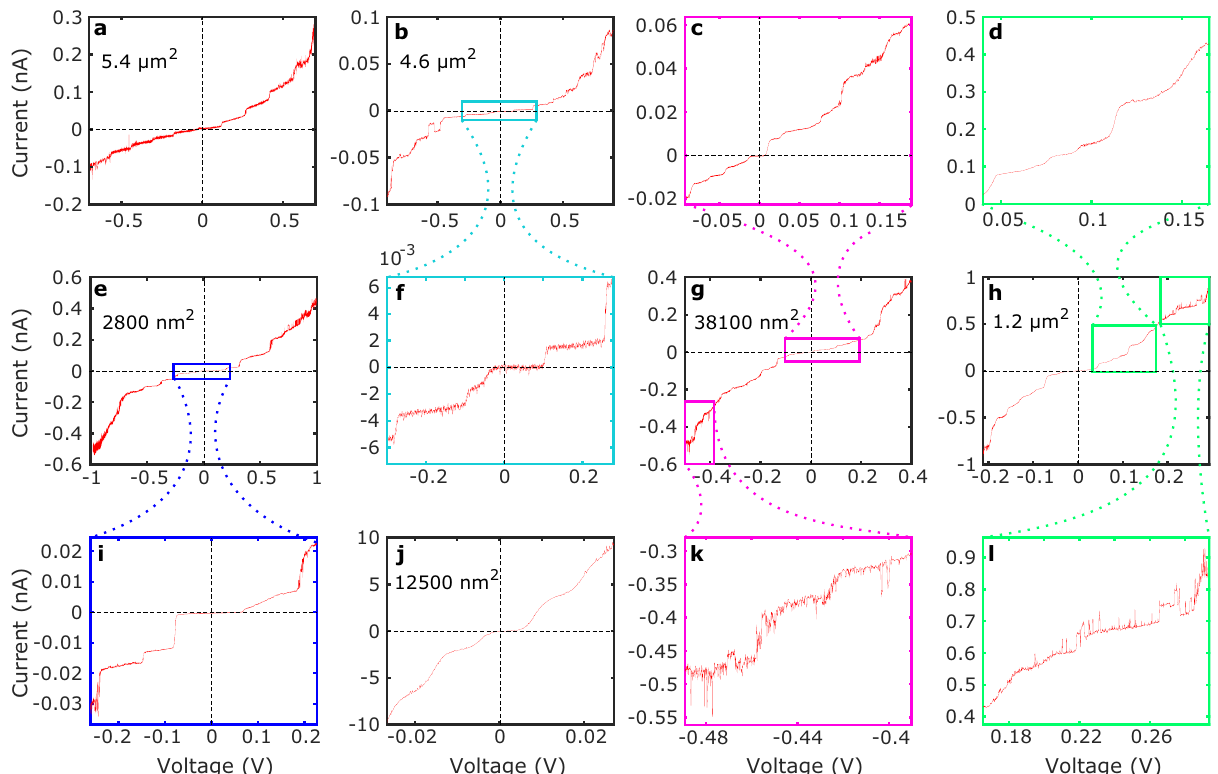
Fig. 2 Devices made using optical (OL) or electron-beam (EBL) lithography, displaying Coulomb-staircase behaviour ( ‘ step curves ’ , StC). The sweep direction is reversed when each device reaches a voltage where its staircase becomes unresolvable, so the voltage range never exceeds ± 1 V. The step width Δ V and height Δ I vary between and within devices. All sweeps show random telegraph noise (RTN) and resistances ~ M Ω . The selected sweeps are representative of the dataset. Devices show a high degree of stability over up to 100 sweeps. a I – V measurement showing a StC in an OL device with a ~5.4 μ m 2 area. The differential conductance at 0 V ( G 0 ) is 1.1 × 10 − 9 S/ μ m 2 and the device shows distinct current plateaux in the range ∣ V ∣ < 1 V.